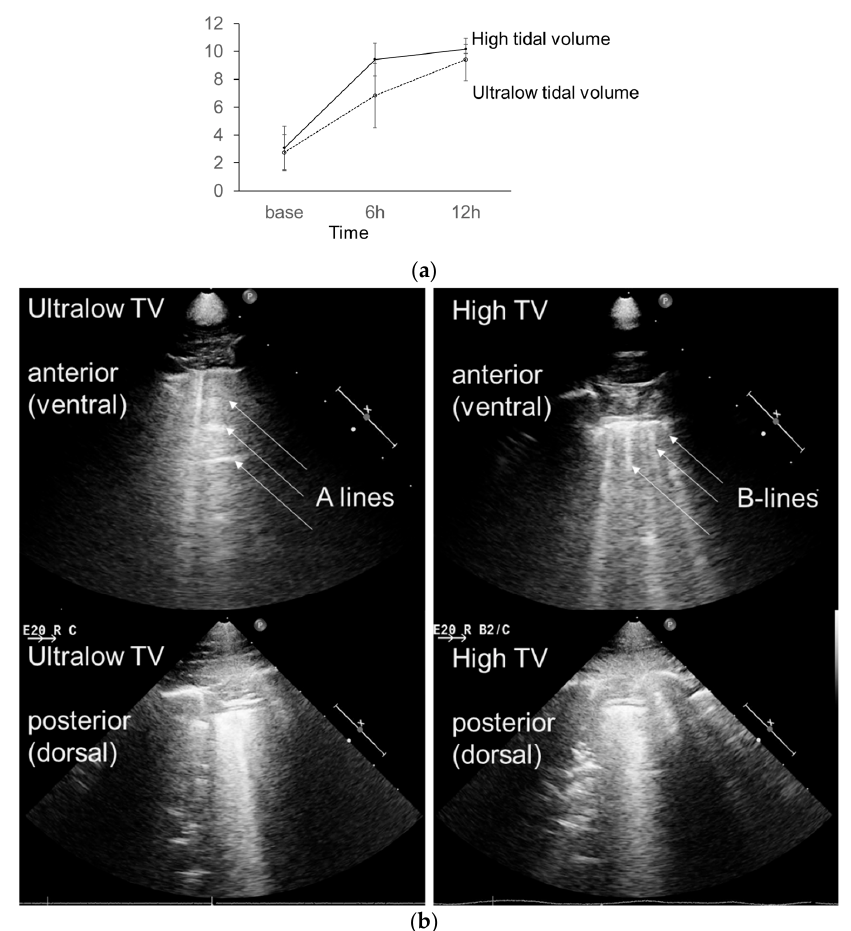
Figure 4. ( a ) Changes in lung ultrasound score, with the straight line depicting the high-tidal-volume ventilation group and the dotted line depicting the ultralow tidal ventilation group under ECMO support. ( b ) The lung ultrasound shows A lines (upper left panel) and typical B lines (upper right panel) in the anterior fields of the right hemithorax, with and without ECMO support, respectively. The lung ultrasound shows multiple B-lines with consolidation (lower panel) in the posterior fields of the right hemithorax of both groups; h: Hour.